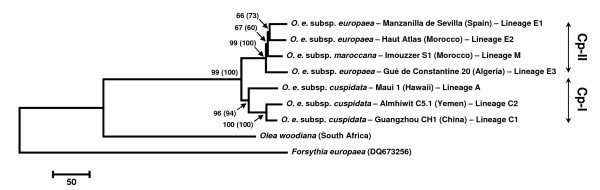
Plastid DNA phylogenetic tree of the seven olive tree lineages based on nucleotide substitutions from complete plastid genomes. The same topology was obtained with maximum parsimony and maximum likelihood (GTR+I+G) analyses. The bootstrap values are given on each branch (when superior to 50%), the first corresponding to the MP analysis and the second (in brackets) to the ML analysis. The Forsythia europaea and Olea woodiana sequences were used as outgroups. The tree was rooted with the Forsythia sequence. The two clades Cp-I and Cp-II are indicated according to Besnard et al. [15].